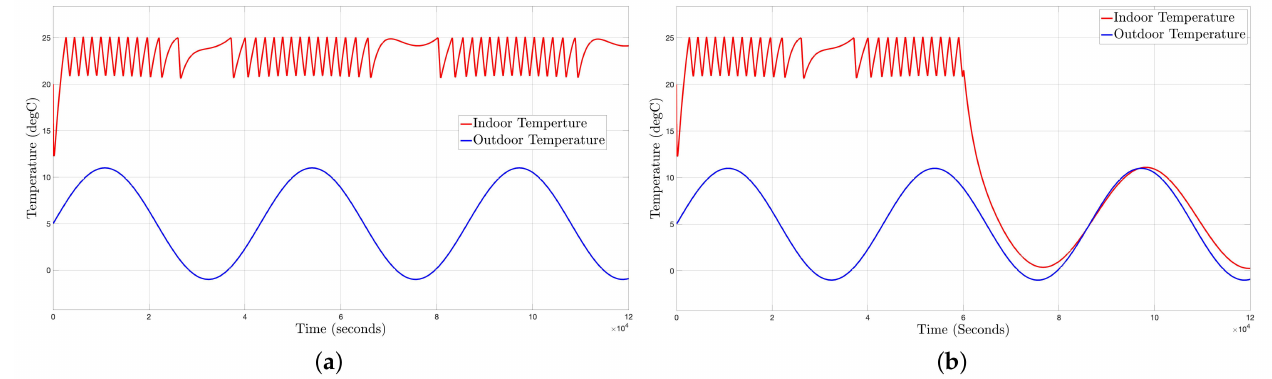
Figure 6. The Temperature Under Regular and Attack. ( a ) The Indoor and Outdoor Temperature Without Attack. ( b ) The Indoor and Outdoor Temperature Under Attack.